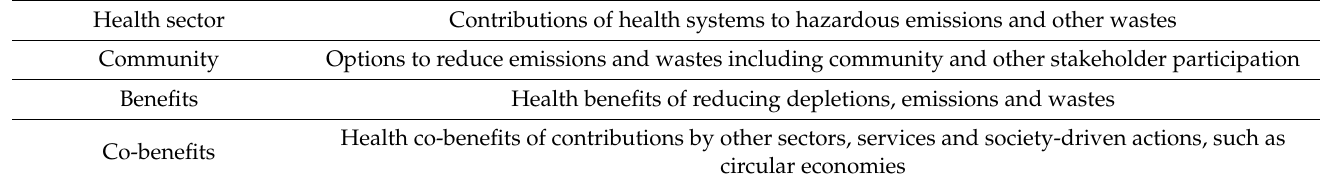
Table 6. Sub-competencies for Domain 5: Mitigation, adaptation and health co-benefits. Health